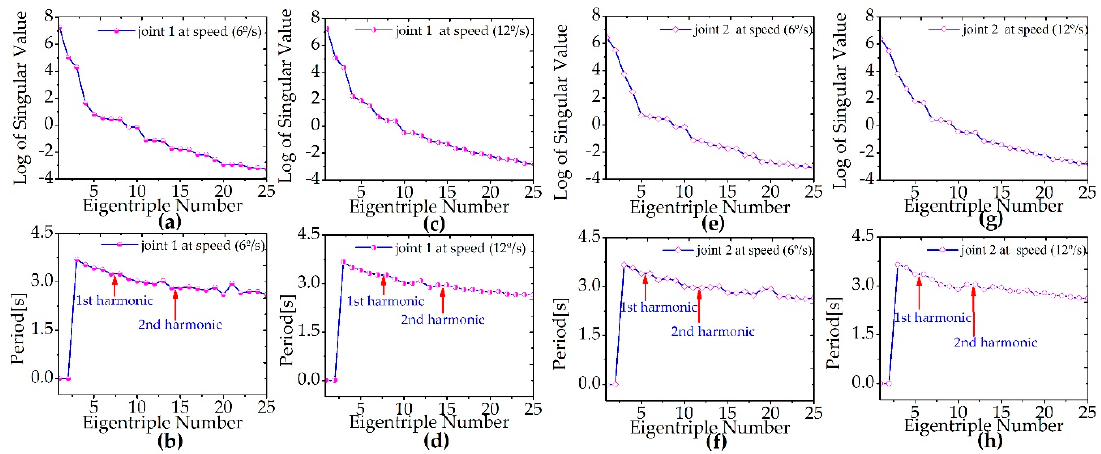
Figure 14. The response of the position oscillations in joint 1 and joint 2 at two speeds with payload 4kg: ( a ) Singular spectrum in joint 1 at 6°/s, ( b ) period spectrum in joint 1 at 6°/s, ( c ) singular spectrum in joint1 at 12°/s, ( d ) period spectrum in joint 1 at 12°/s, ( e ) singular spectrum in joint 2 at 6°/s, ( f ) period spectrum in joint 2 at 6°/s, ( g ) singular spectrum in joint 2 at 12°/s, ( h ) period spectrum in joint 2 at 12°/s.